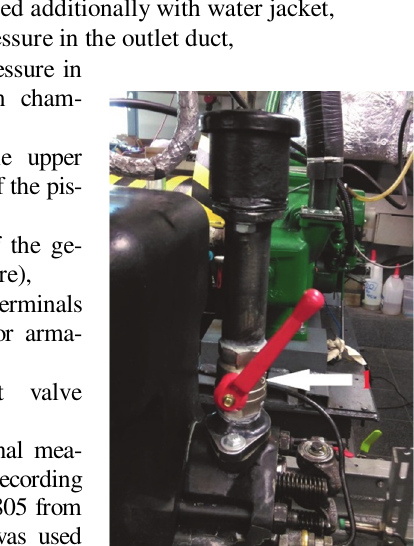
Fig. 1. A view of the inlet air duct supplying the engine: 1 – supply air control valve (degree of shutdown of the valve as during the